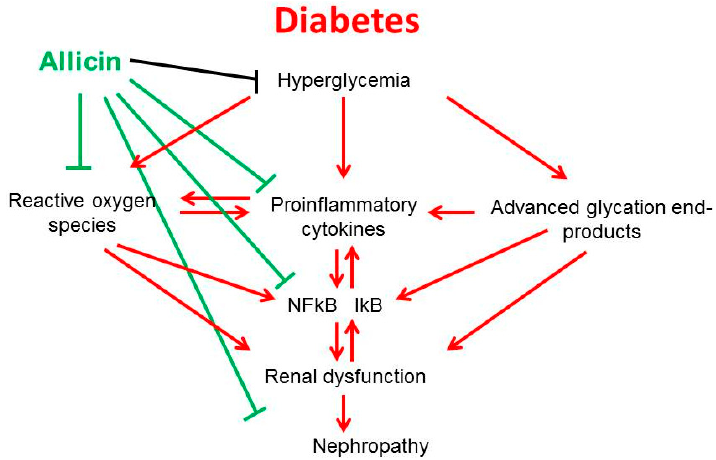
Figure 7. Anti-inflammatory mechanism of allicin in diabetic kidney. Red lines show the effect of diabetes and green lines effect of allicin. diabetes and green lines effect of